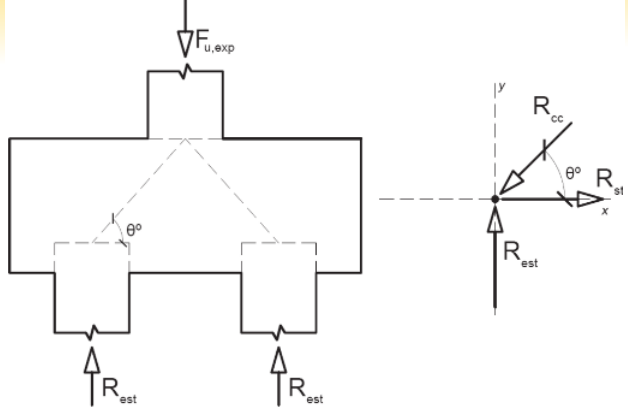
Equilíbrio das forças na região nodal inferior para cálculo de R (resultante no tirante) e R st